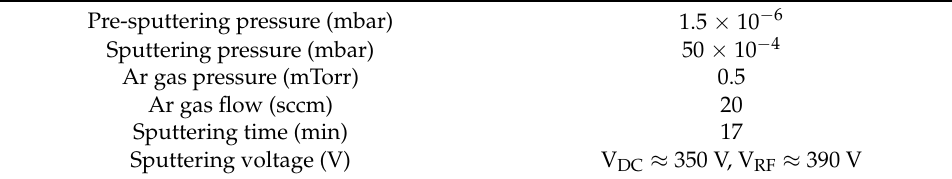
Table 1. Typical deposition parameters for sputtering